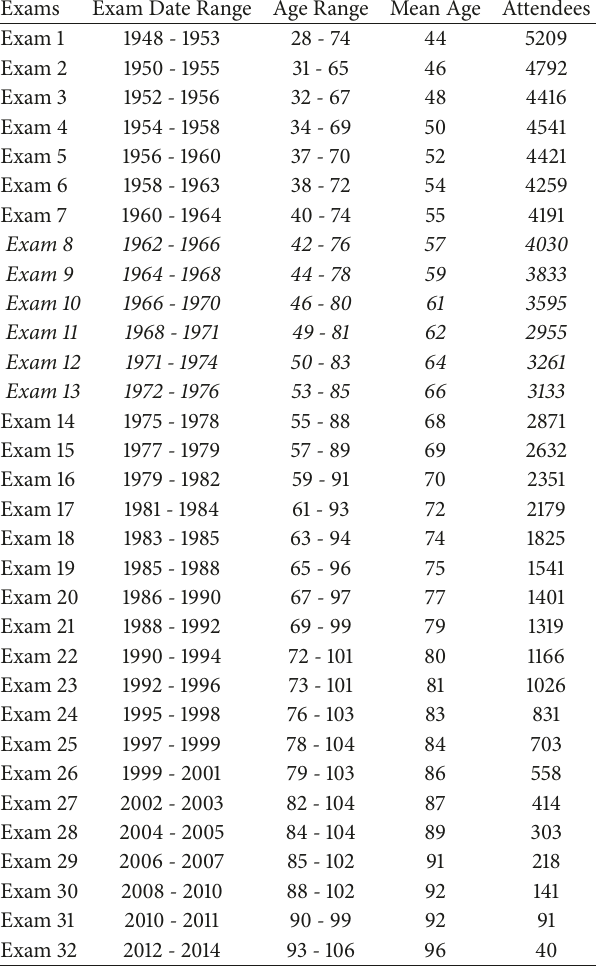
Table 7: Exams in the Framingham Original Cohort study data